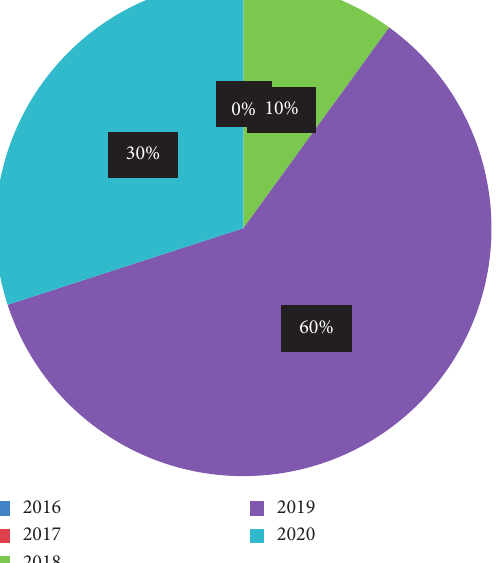
Figure 7: Percentages of articles in the specified years.